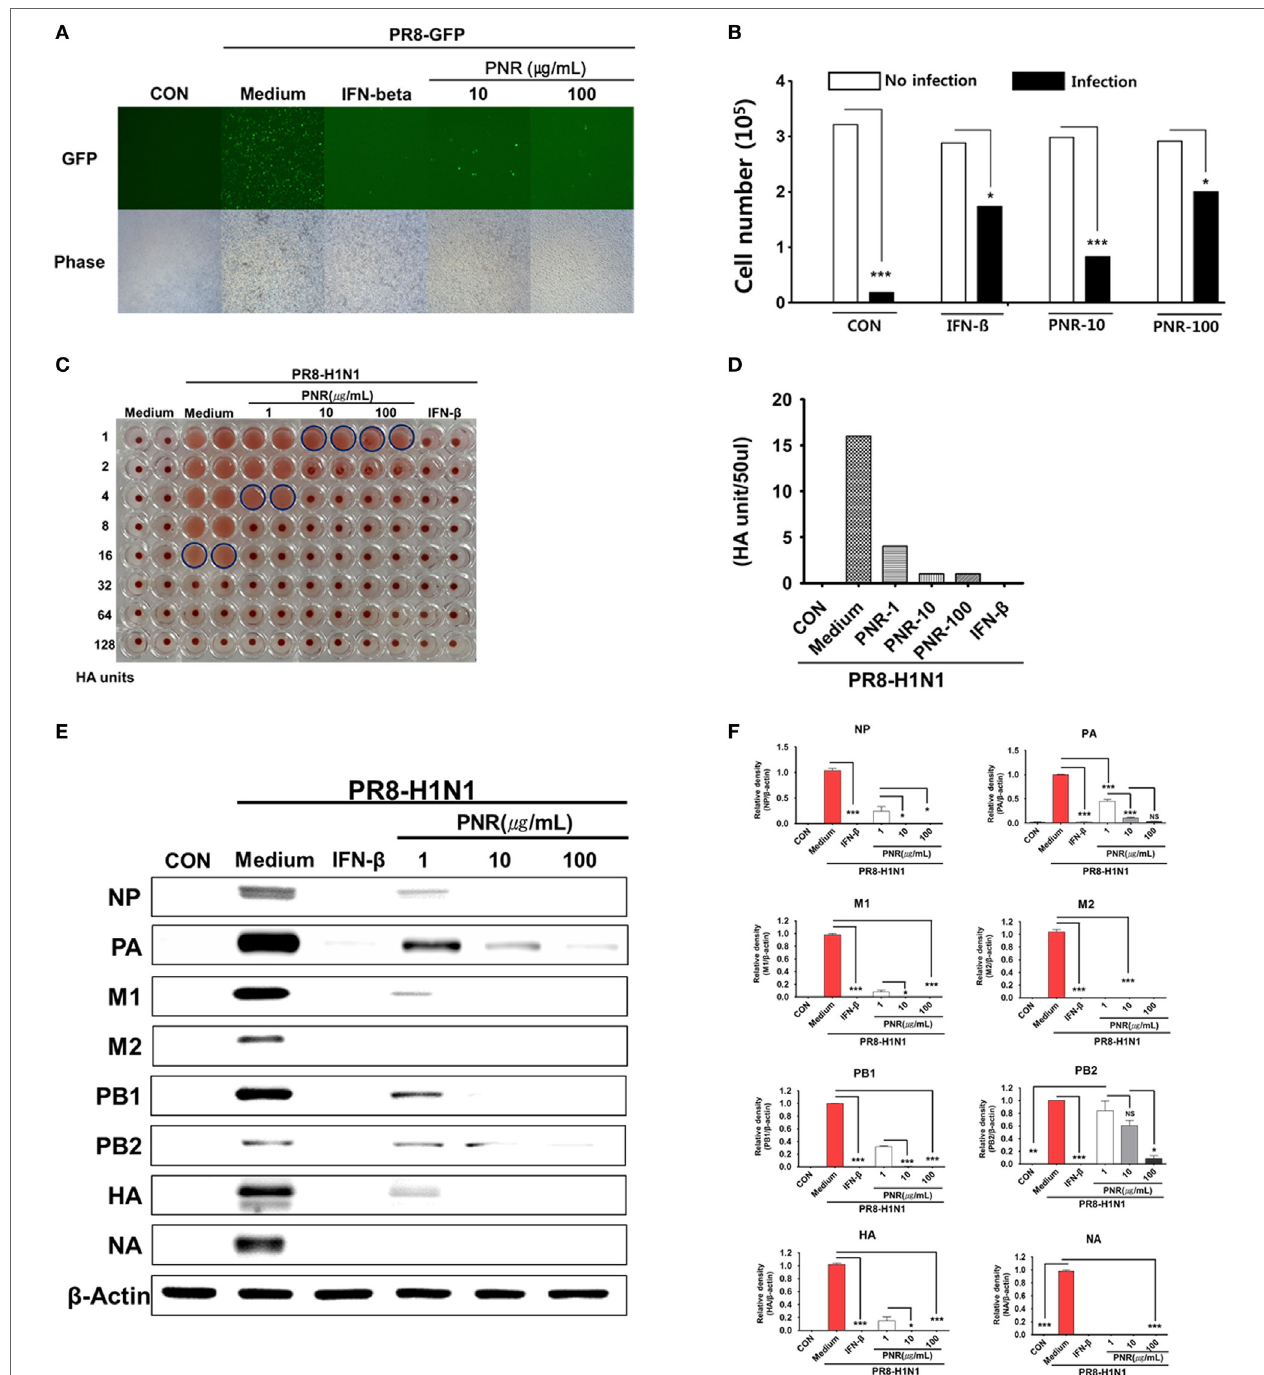
FigUre 4 | Antiviral activities of Panax notoginseng root (PNR) on the influenza A/PR/8/34-GFP virus in RAW 264.7 cells. (a) RAW 264.7 cells were treated with PNR (10 and 100 µg/mL) prior to A/PR/8/34-GFP infection, and cells were incubated with medium alone, 10 or 100 µg/mL PNR, or 1,000 U/mL interferon (IFN)- β 12 h prior to infection with A/PR/8/34-GFP (multiplicity of infection = 1). Images of GFP expression were obtained 24 h after virus infection. (B) Cell counts and viabilities were determined 24 h after virus infection using the trypan blue exclusion analysis. Statistical significance between values obtained for virus infection and no virus infection cells was determined using Chi-square test and Bonferroni’s correction (post-test), *** P < 0.001; * P < 0.05; n.s., not significant. (c,D) Viruses were titrated from the supernatant via the hemagglutination assay. (e,F) RAW 264.7 cells were treated with PNR (1, 10, or 100 µg/mL), IFN- β (1,000 U/mL), or medium alone (negative control). Influenza A/PR/8/34 A virus protein levels (NP, PA, M1, M2, PB1, PB2, HA, and NA) in cell lysates were analyzed by Western blotting, and β -actin expression was analyzed as an internal control. Similar results were obtained, and the experiment was performed three times independently. Bar graph (mean ± SEM) statistics were determined using two-way ANOVA with Bonferroni’s correction (post-test), *** P < 0.001; ** P < 0.01; * P < 0.05. n.s., not